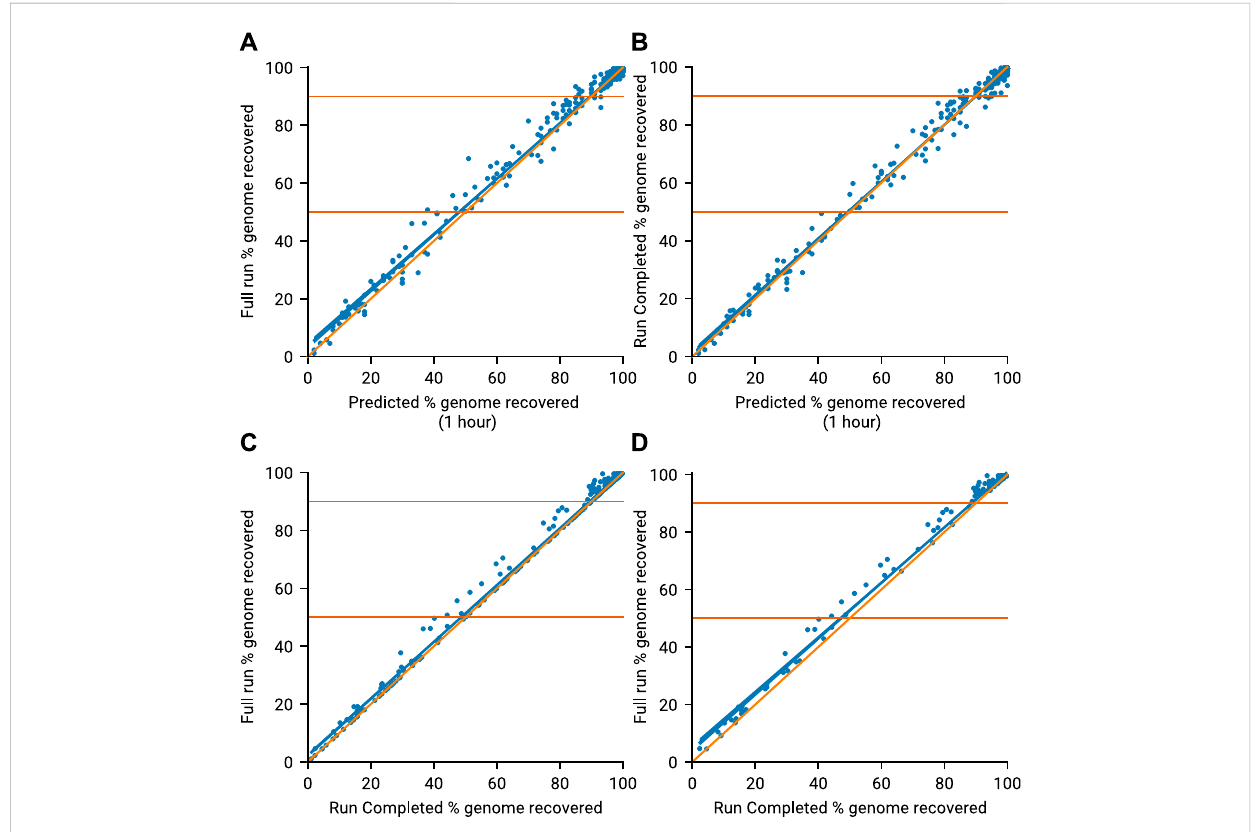
FIGURE 3 Genome recovery throughout all 13 runs. Blue line (line of best fi t), Orange line ( x = y ). (A) Compares the predicted genome recovery based on 1 hours sequencing ( X -axis) with the actual coverage seen at the end of the run ( Y -axis). Predicted recovery is the proportion of amplicons in a sample expectedtoreach20×coverage.ActualcoverageistheproportionofnonNbasesintheconsensusgenomesobtainedattheendoftherun(FullRun). (B) Compares the same predicted genome recovery with the actual coverage observed at the Run Complete time as de fi ned by minoTour. (C) ComparestheactualcoveragesreportedinA(FullRun)andB(RunComplete). (D) IsthesameasCbutignoresthoserunswheretheRunCompletetimeis the same as the Full Run